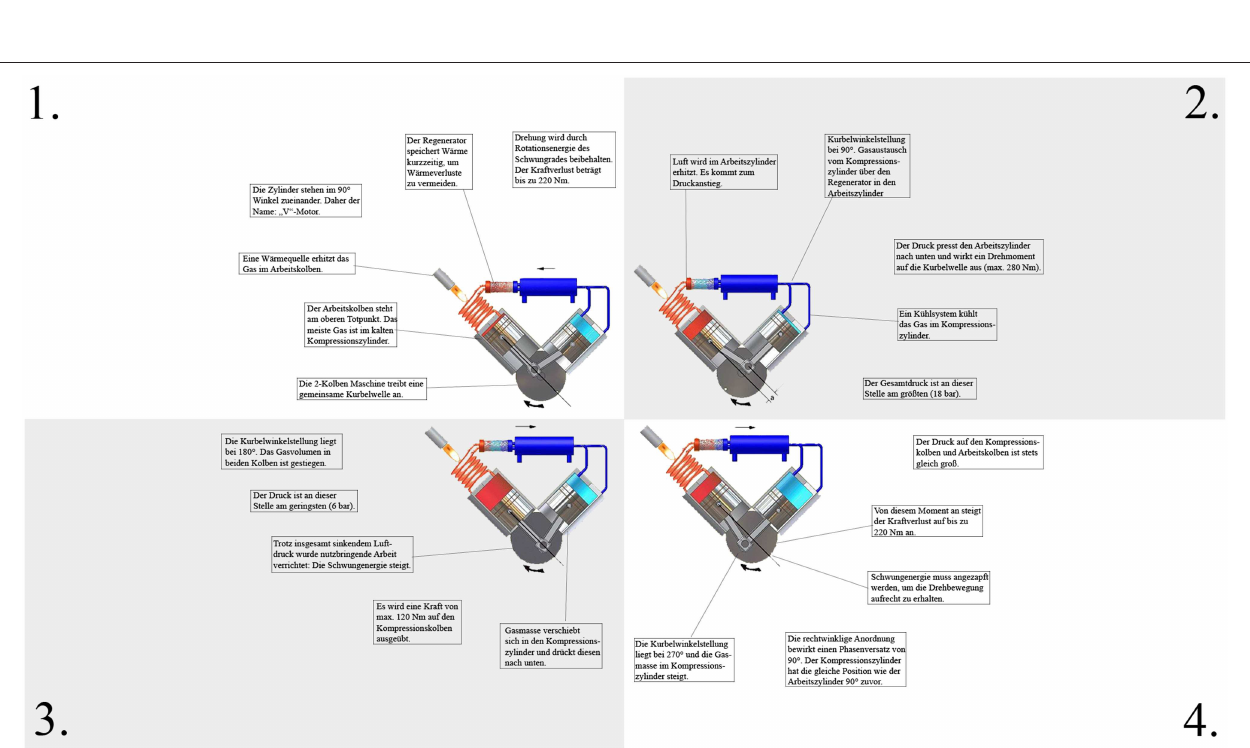
FIGURE 7 | Integrated text-picture presentation with medium spatial proximity in Experiment